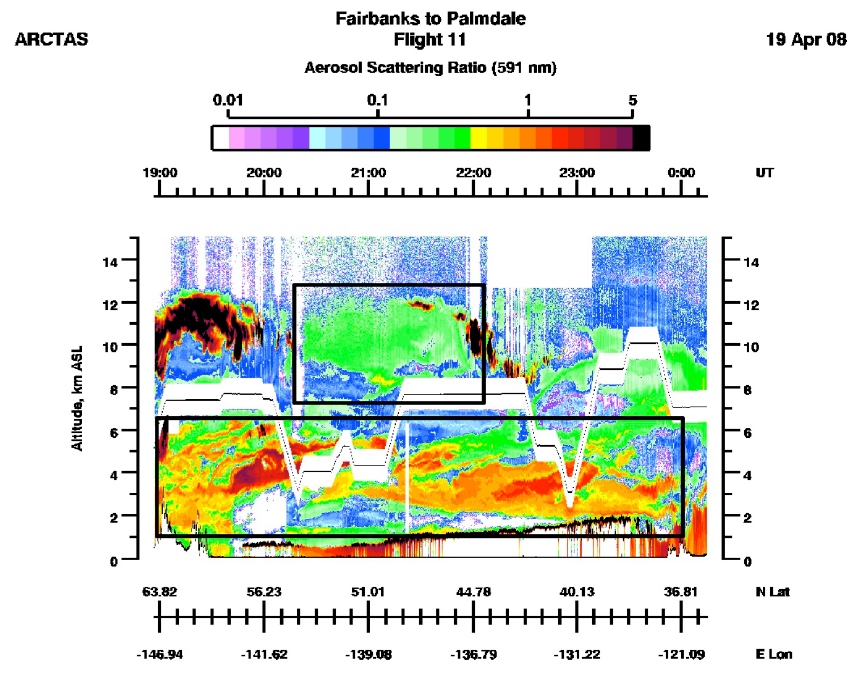
Fig. 4. Aerosol Scattering Ratio (ASR) from the Differential Analysis Lidar during DC8 flight 11 and square limiting aerosol plumes.